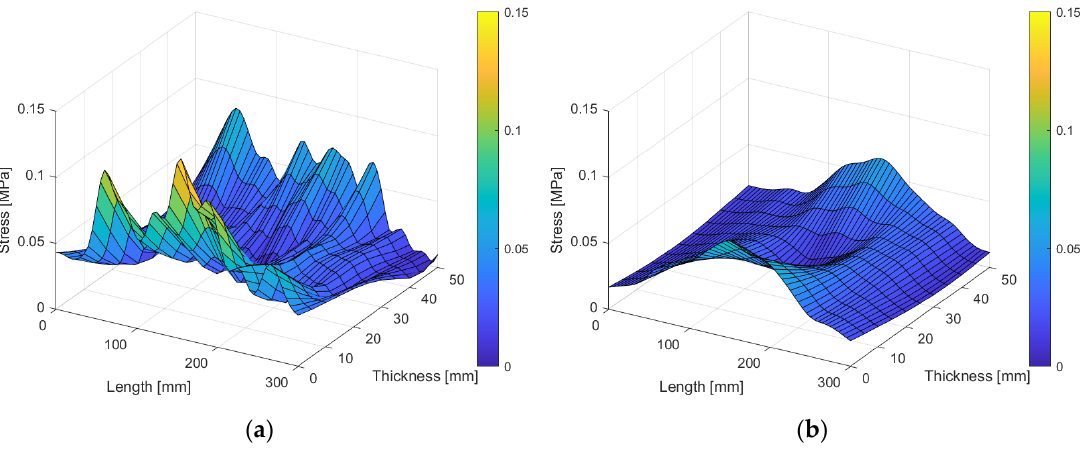
Figure 16. Von Mises stress contour according to the corrected influence domain radius. ( a ) Conventional radius of influence domain ( r ) optimized for 42 TPs, and ( b ) doubling the radius of domain of influence (2 r ) at t = 60 s.